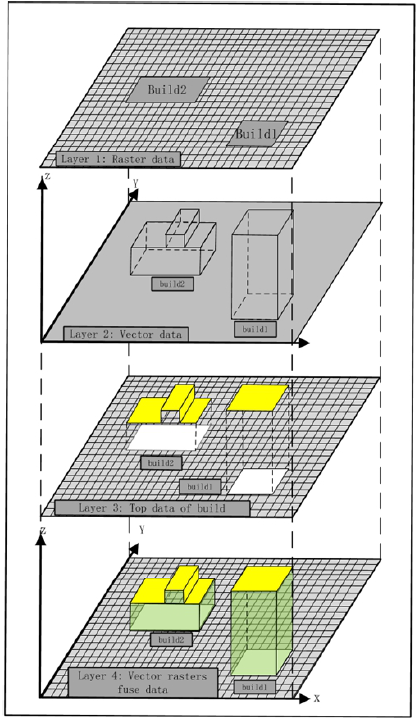
Figure 4. Schematic diagram of vector raster data layered As shown in Figure 4: